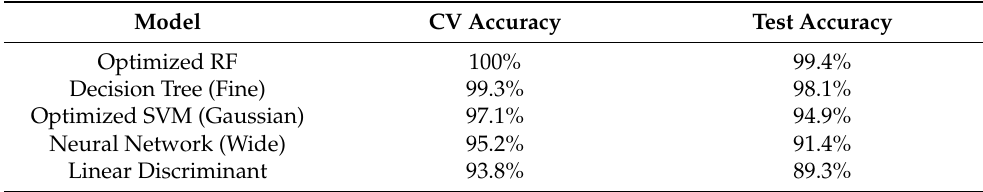
Table 2. Test accuracy of ML models with 18 features for FTC with FP.